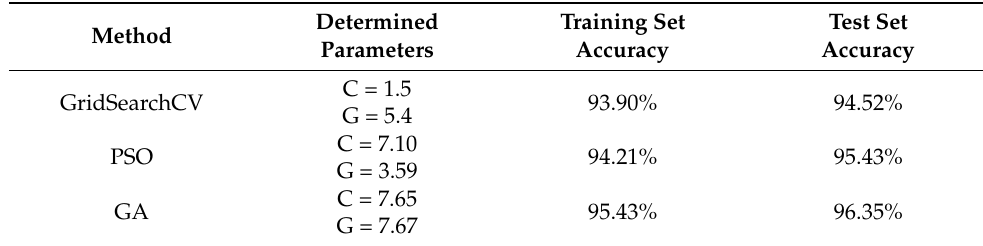
Table 6. The optimal parameters determined by three methods and the corresponding classification accuracy.